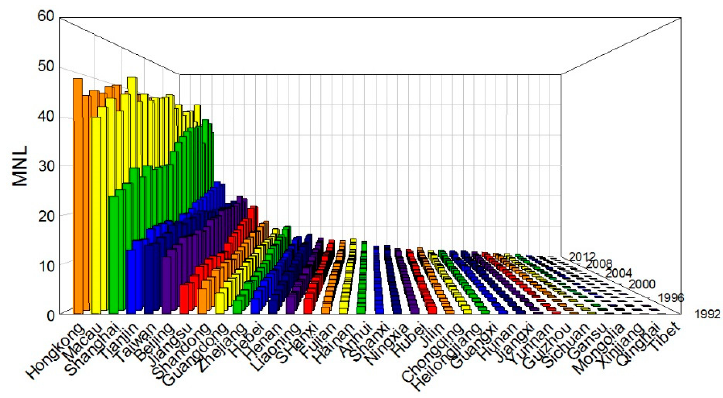
Figure 10. Mean nighttime light (MNL) at the provincial scale in China.